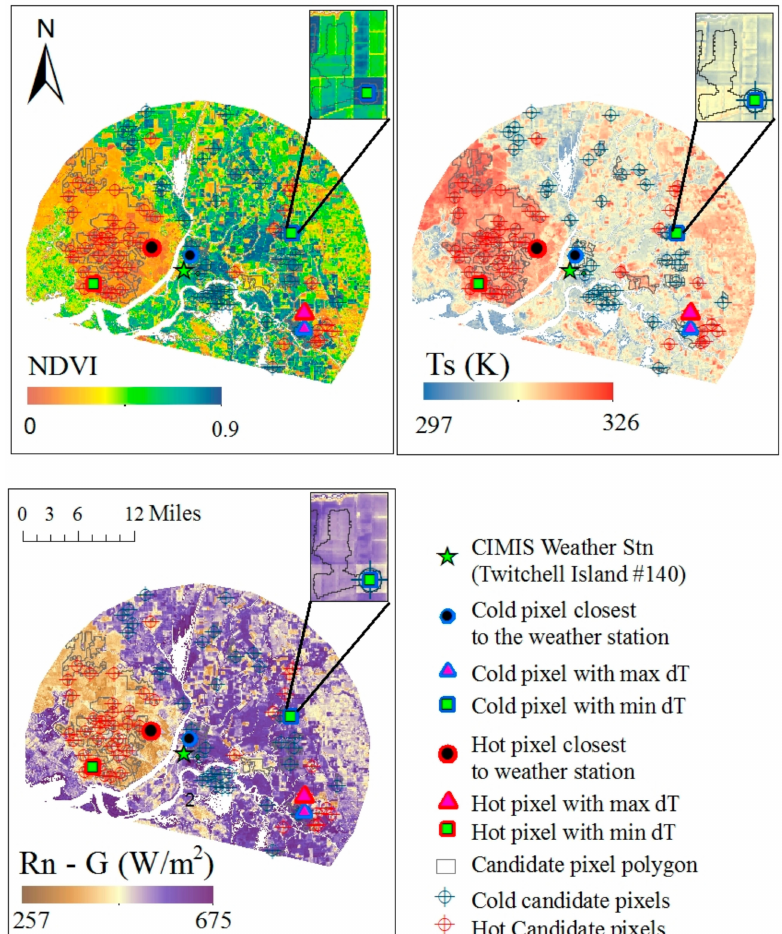
Figure 6. Location of hot and cold calibration pixel sets as polygons (24-07-2014). Inset shows a polygon from which the cold calibration pixel was selected and has minimum dT